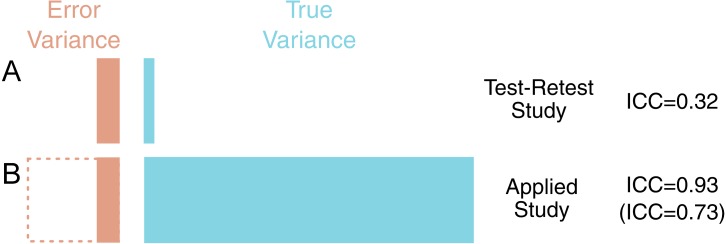
Demonstration of the outcomes of Example 1.Left are shown the proportional contributions of error and true variance to the total variance for the different studies (Test Retest A, Applied B). The difference in the variance of different samples can be extreme, and the results of test-retest studies examining young, healthy individuals can require re-calibration when examining new samples with very different characteristics, in this case spanning a wide age range. Below left, shown with dashed lines, is shown that even in a worst-case scenario of measurement error (\documentclass[12pt]{minimal}
\usepackage{amsmath}
\usepackage{wasysym}
\usepackage{amsfonts}
\usepackage{amssymb}
\usepackage{amsbsy}
\usepackage{upgreek}
\usepackage{mathrsfs}
\setlength{\oddsidemargin}{-69pt}
\begin{document}
}{}${\hat {\sigma }}_{e}$\end{document}σ ˆe) being doubled in this new sample (and thereby variance quadrupled), this can still be compensated for by the larger true variance (ICC right in brackets).